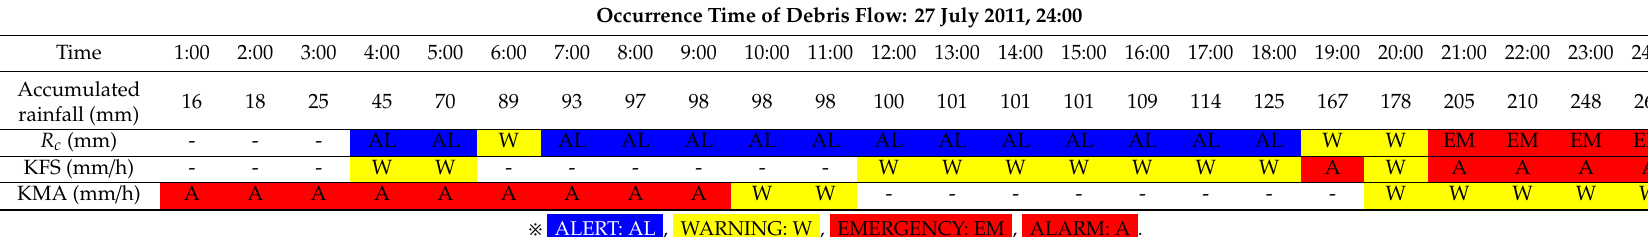
Table 7. Comparison of debris flow forecasting level results (Case